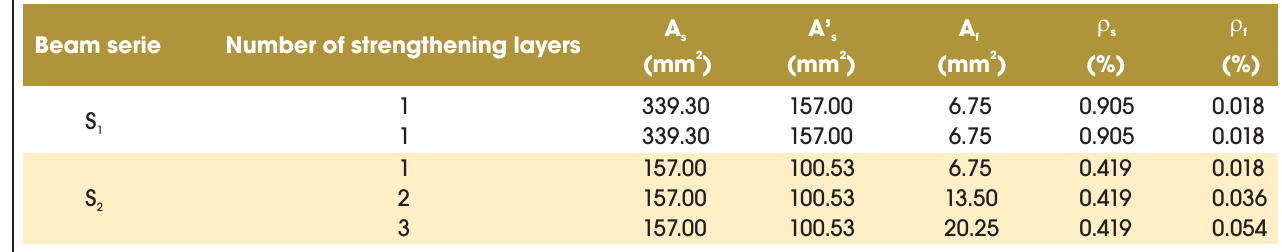
Table 2 – Amount of internal reinforcement and strengthening in each